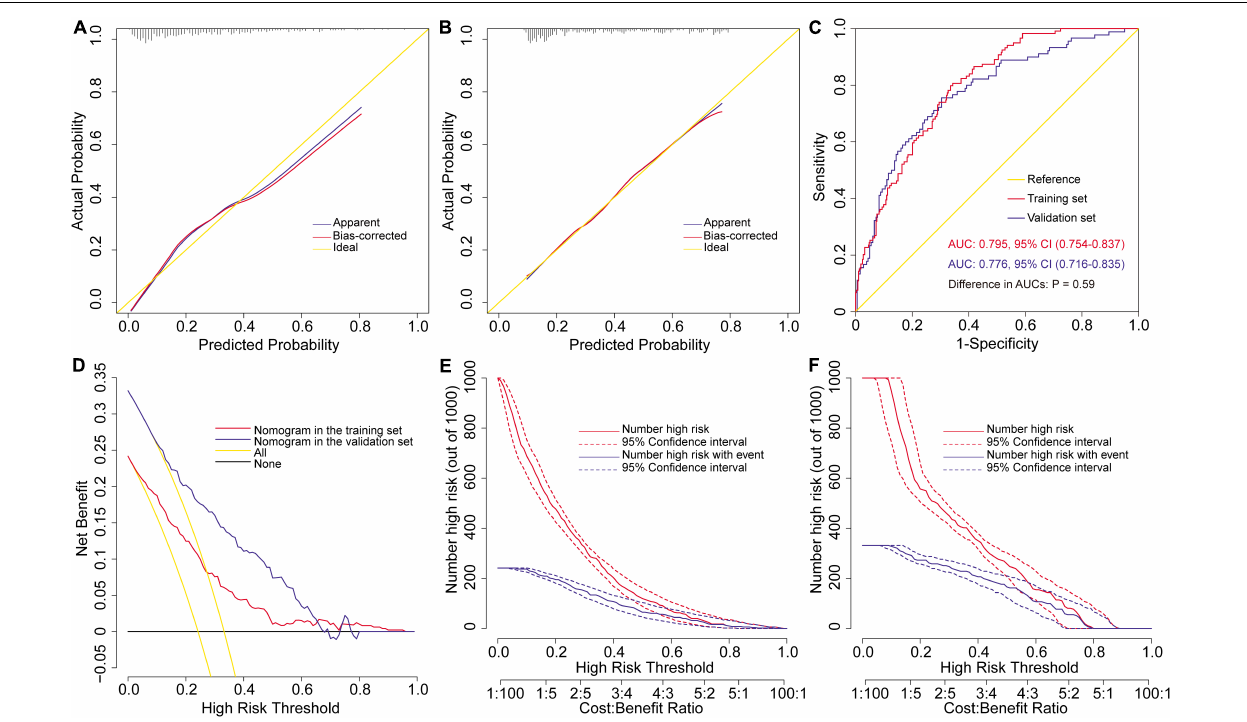
FIGURE 3 | Assessment and validation of the preoperative nomogram for severe hypoxemia in patients undergoing Stanford type A acute aortic dissection surgery. Calibration plots in the training set (A) and the validation set (B) , ROC curves in the two sets (C) , decision curves in the two sets (D) , and clinical impact curves in the training set (E) and the validation set (F) . AUC, area under the receiver operating characteristic curve; CI, confidence interval; ROC, receiver operating characteristic curve.